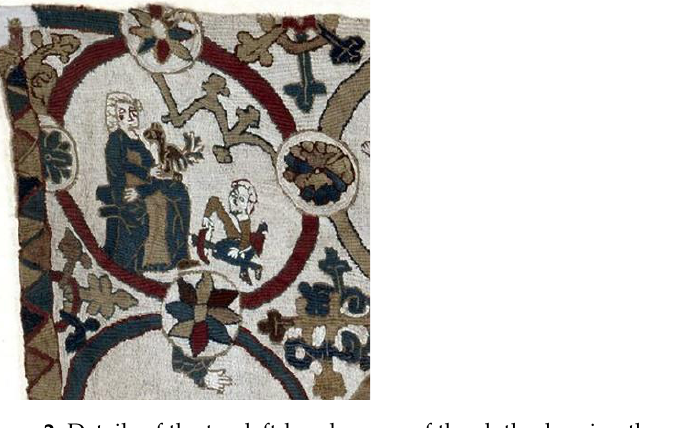
Figure 2. Details of the top left-hand corner of the cloth, showing the partially shortened blue arch on top of the red circle. Additionally, note the lute player and falcon with a hood.